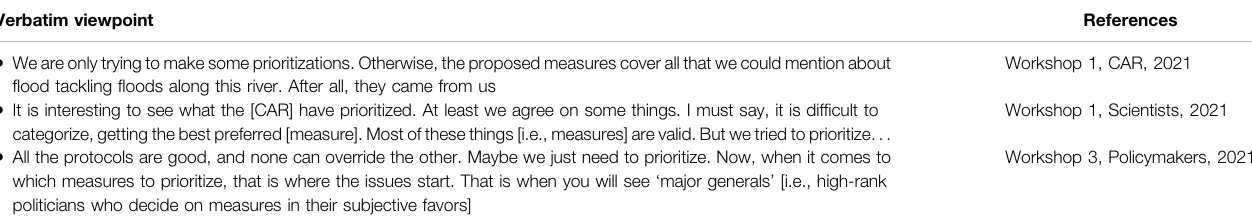
TABLE 1 | Sample viewpoints of participants when asked to prioritize measures among the inventory and add more. Verbatim